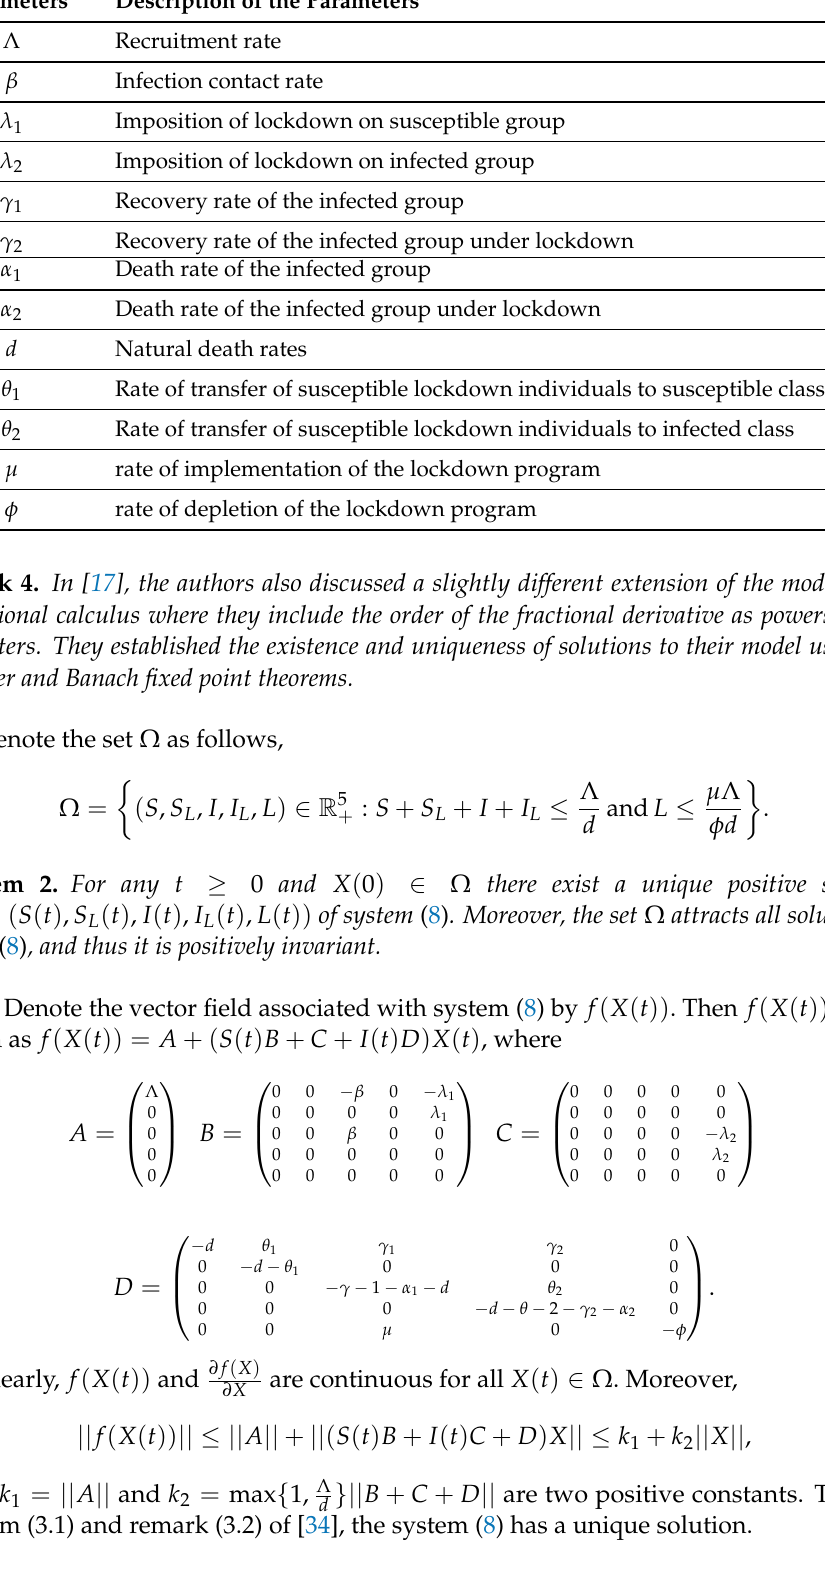
Table 1. Description of the parameters used in the COVID-19 epidemic model (8) .